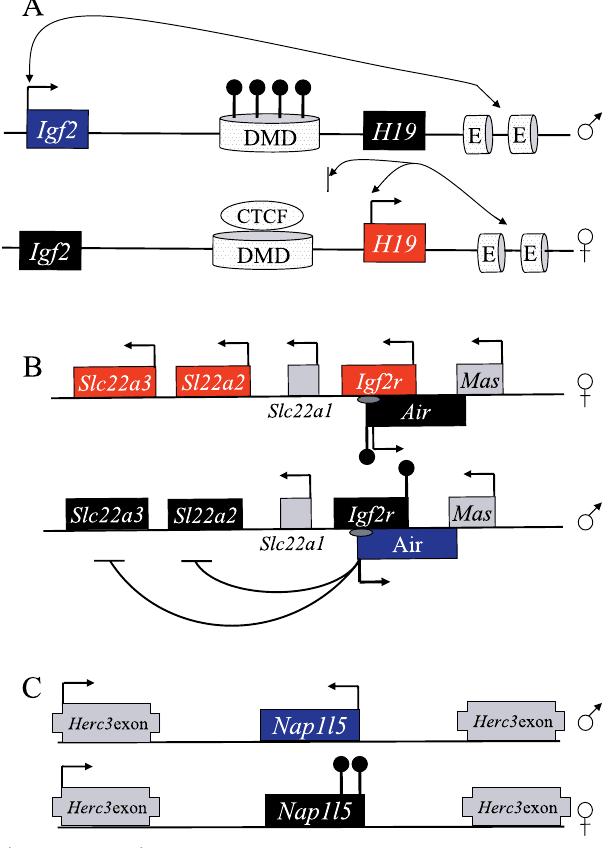
Figure 2. Regulatory Models at Imprinted Loci Blue boxes represent paternally expressed alleles, red boxes maternally expressed alleles, black boxes silenced alleles, and grey boxes nonimprinted genes. Arrows on boxes indicate transcriptional